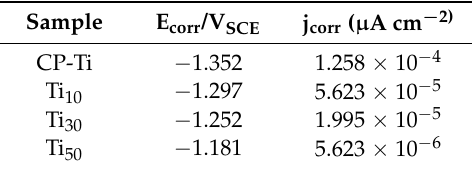
Table 3. Electrochemical parameters of the CP-Ti, Ti 10 , Ti 30 and Ti 50 in 3.5 wt.% NaCl solution at room